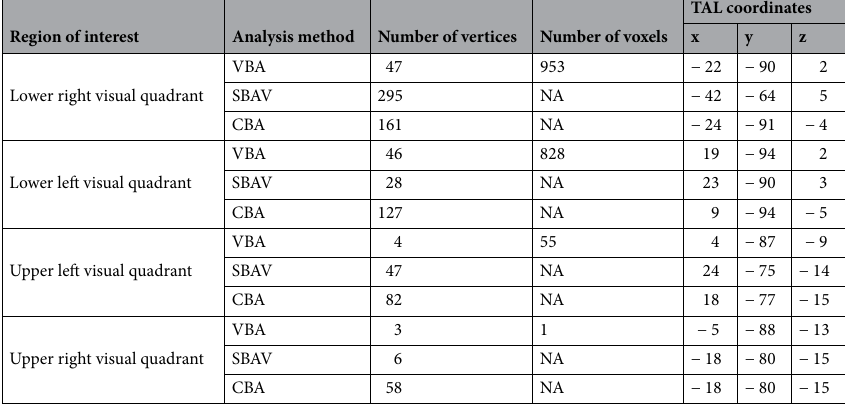
Table 1. Group ROIs. Size and Talairach coordinates of the group ROIs of the corresponding visual quadrants for the VBA, SBAV and CBA data sets. For ROI size comparison, we focused exclusively on the number of vertices. Importantly, we only provide the number of voxels of each VBA ROI as a reference to ensure a comprehensive reporting of our findings. In three out of four visual quadrant ROIs we observed the largest cluster size for CBA, which is indicative of the highest degree of position selectivity for the most advanced alignment technique.